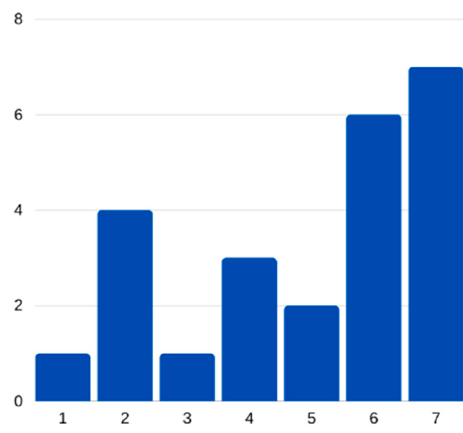
Figure 25. EverAnalyzer correct suggestion streaks.